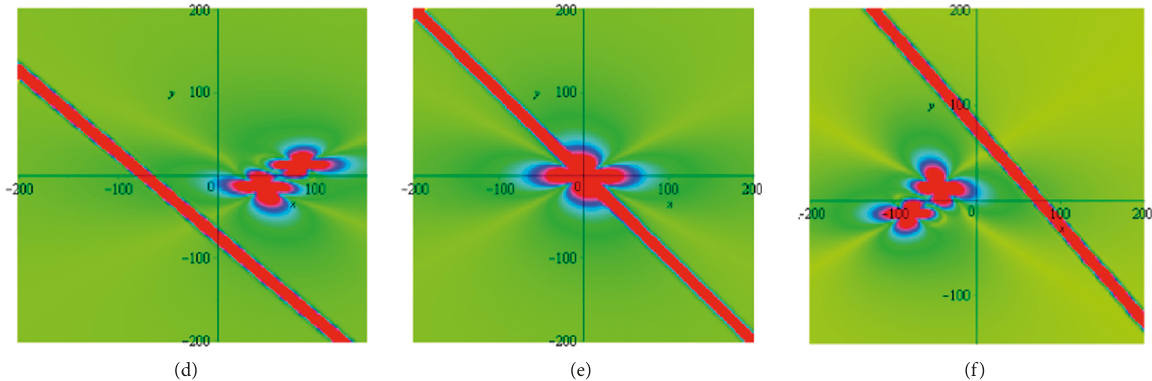
Figure 28: Plots of equation (91) by taking ϕ